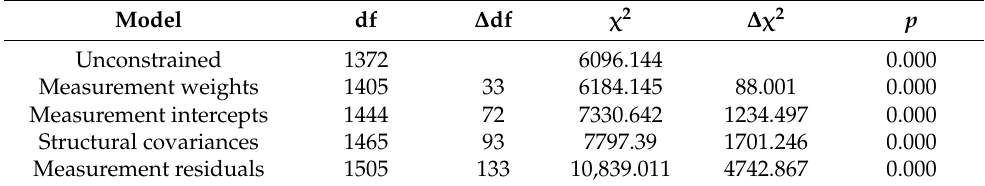
Table 1. Multigroup